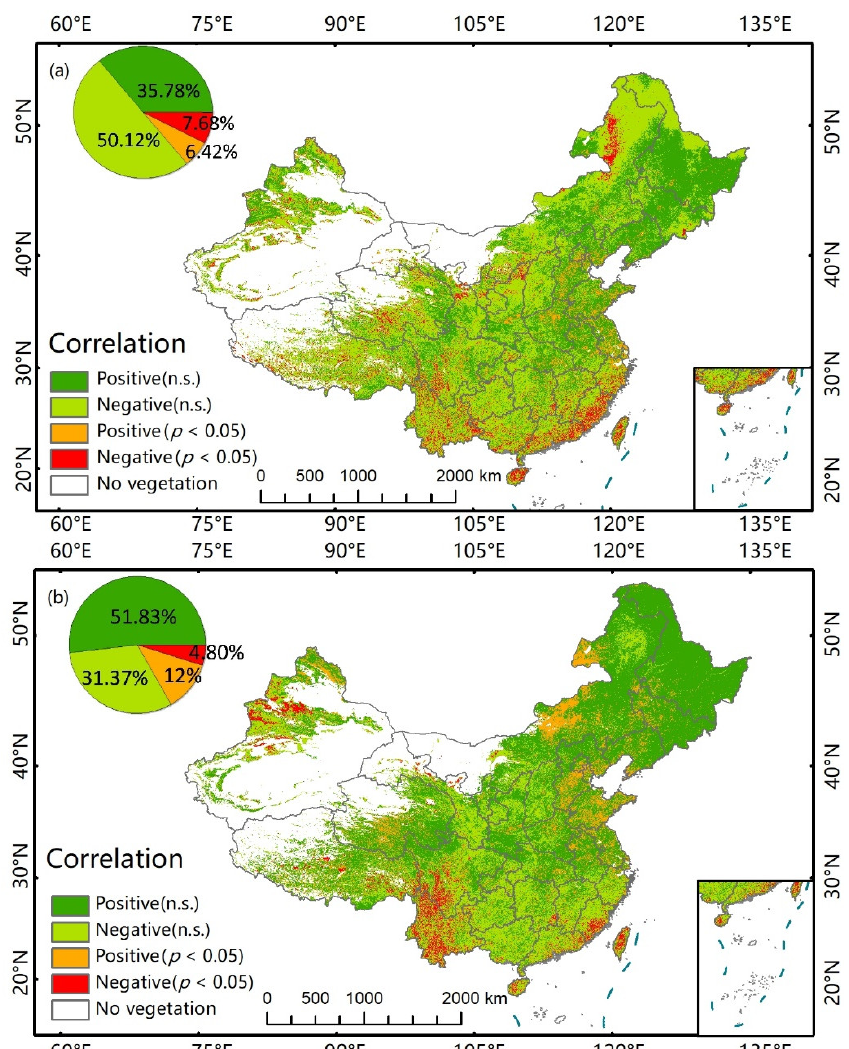
Figure 6. ( a ) Correlation between the NDVI and temperature in China from 1998 to 2019; ( b ) correlation between the NDVI and precipitation in China from 1998 to 2019. Positive/Negative (n.s.) represents positive/negative correlation that did not pass the significance test. Positive/Negative ( p < 0.05) indicates positive/negative correlation at 95% significance level.